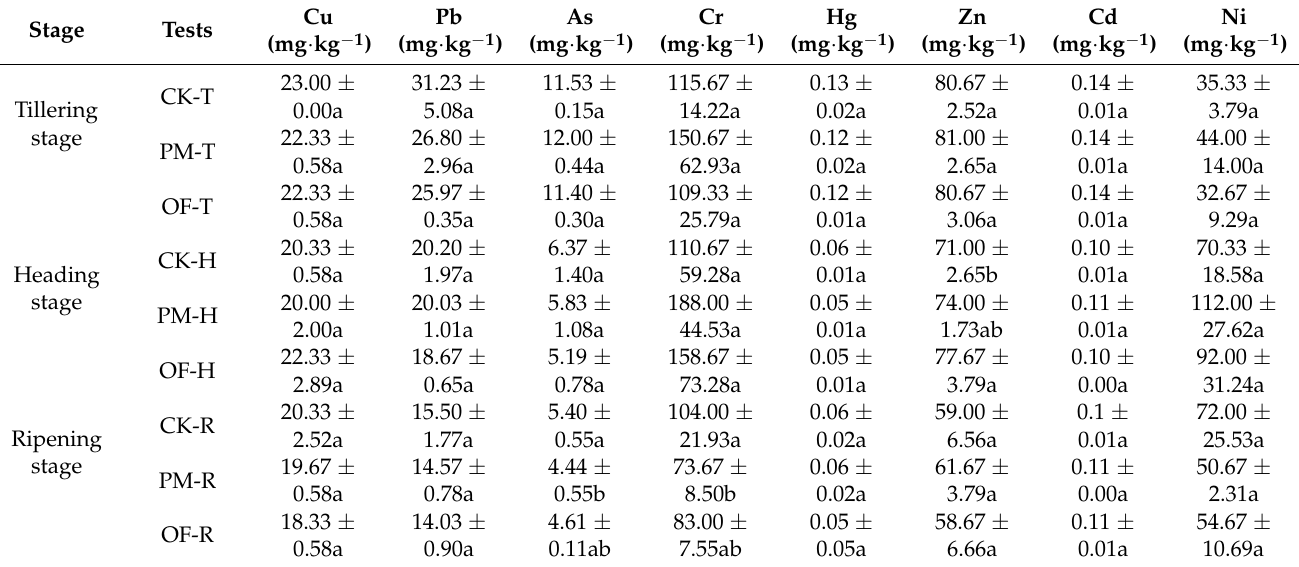
Table 1. Effects of manure application on heavy metals in paddy